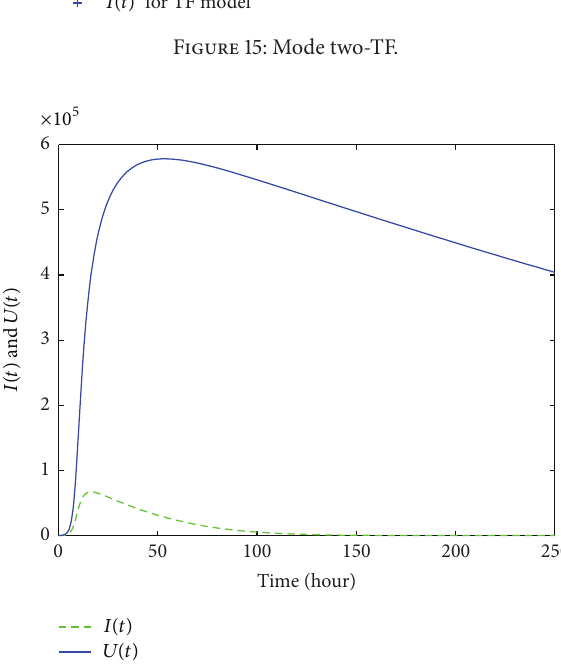
Figure 15: Mode two-TF.